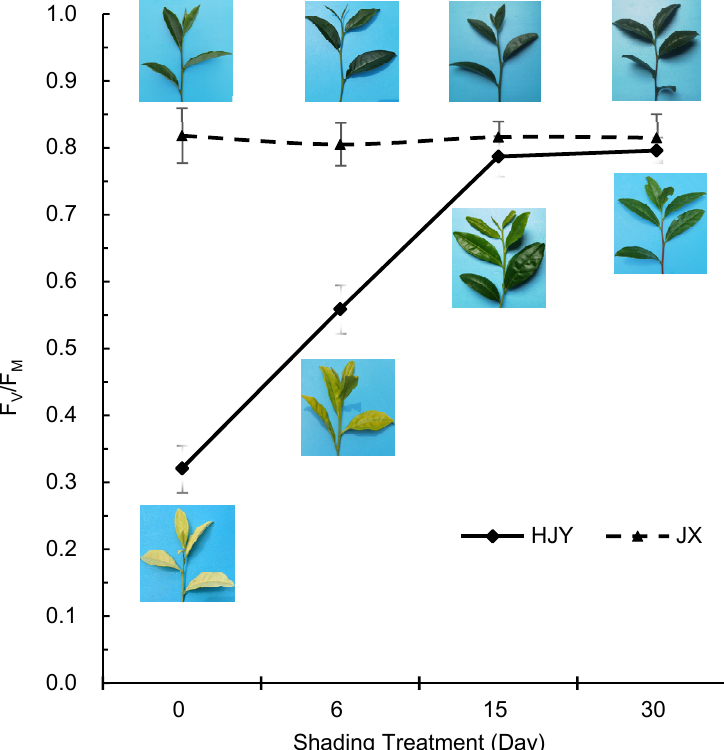
Figure 4. Changes in Fv/Fm during shading treatment period. The Fv/Fm was determined on the 4th leaf beneath apex bud, and 10 leaves were tested each treatment. HJY, cultivar “Huangjinya”; JX, cultivar “Jinxuan”.